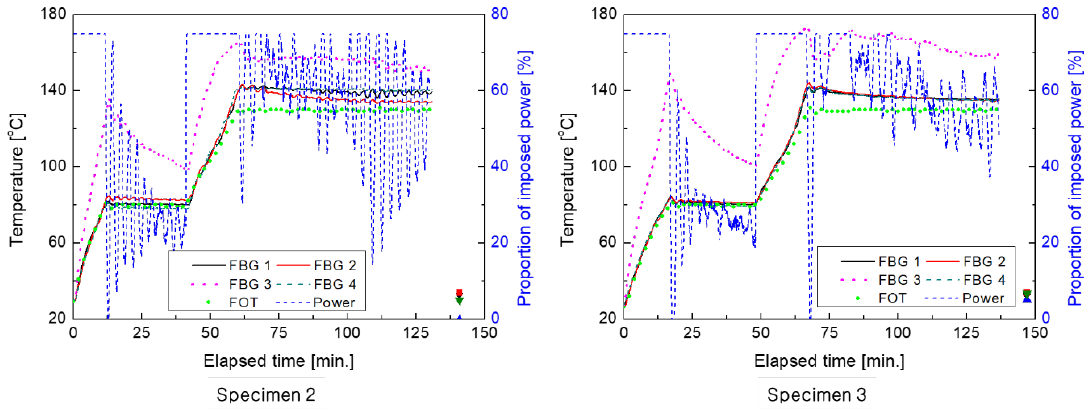
Figure 7. Results of cure monitoring of the other specimens (2 (left), 3(right)).